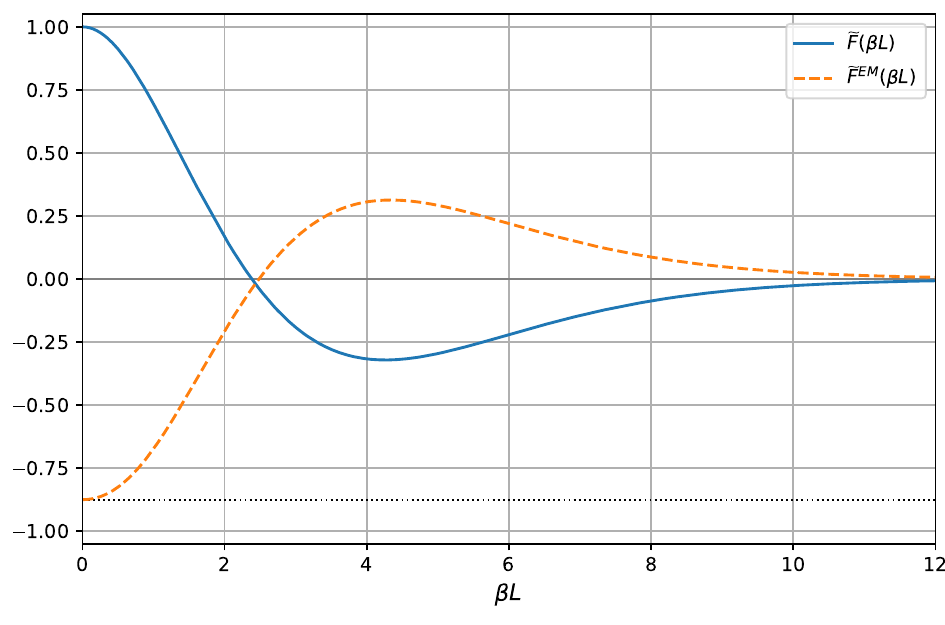
Figure 3 . The relative Casimir force e F ( βL ) between two plates with equal boundary conditions in a chiral medium, and the case where one plate is PEC and the other is PMC, e F EM ( βL ) . The . When the boundary conditions of the plates are equal the dotted line corresponds to e F = − 7 8 Casimir force starts out equal to the QED Casimir force, but becomes repulsive for larger values of βL . Similarly in the PEC-PMC case the Casimir force starts repulsive as the QED result of − 7 8 times the conventional Casimir force but becomes attractive for larger βL